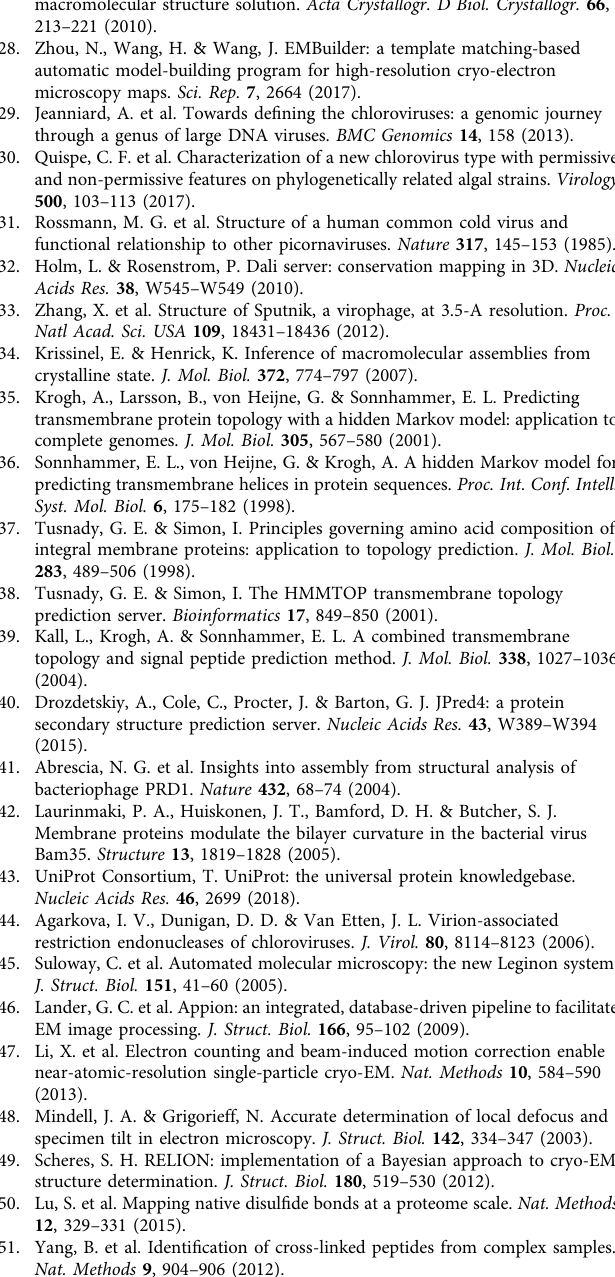
Data availability The atomic coordinates for the major and minor capsid proteins and the cryo-EM density map have been submitted to the Protein Data Bank and Electron Microscopy Data Bank with accession codes 6NCL and EMD-0436, respectively. The authors declare that all other data supporting the fi ndings of this study are available within the article and its Supplementary Information fi les or are available from the authors upon